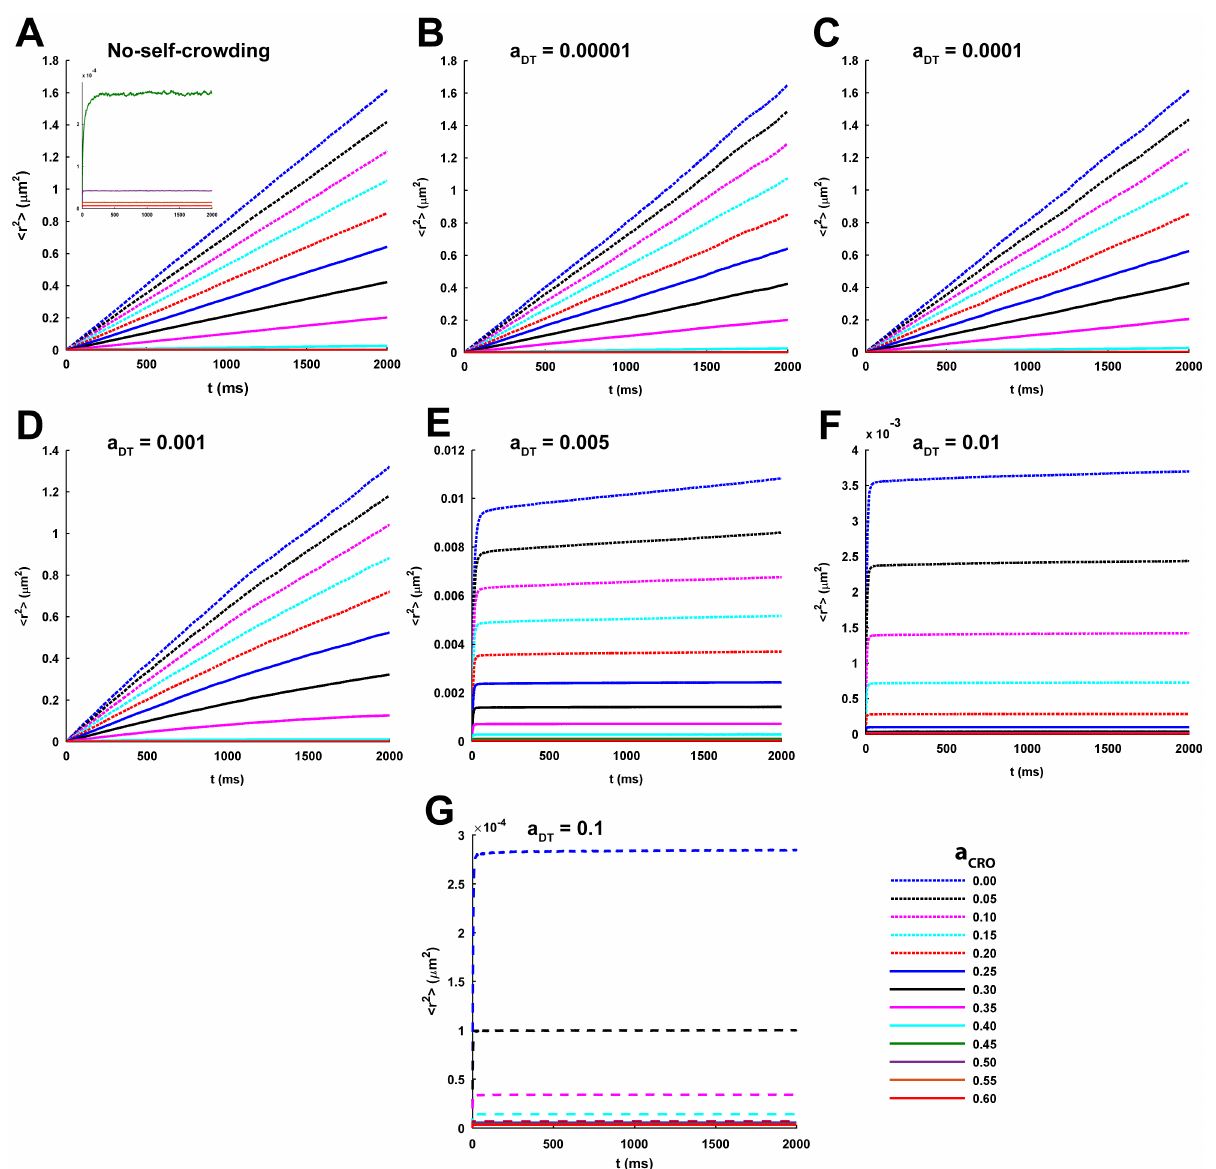
Fig 2. Temporal profiles of ensemble-averaged MSD under different self-crowding conditions and CRO densities. (A-G) Each plot demonstrates the temporal profiles of ensemble-averaged MSD, h r 2 i , across the increasing CRO density, a CRO , for a given condition of self-crowding. The no-self- crowding condition refers to the conventional approach where self-crowding of diffusing tracers is not considered in the simulation and, hence, is regarded here as the standard benchmark for comparison. Otherwise, the different self-crowding conditions are recognized by the density of DTs, a DT , on the lattice with which the diffusion simulation is performed. The tracer diffusion appears normal for lower densities of CROs and DTs where h r 2 i appears to increase linearly with time. However, it becomes strongly subdiffusive-anomalous and confined for the higher CRO and DT densities where h r 2 i reaches a saturation or plateau and no significant increase in MSD occurs further with temporal